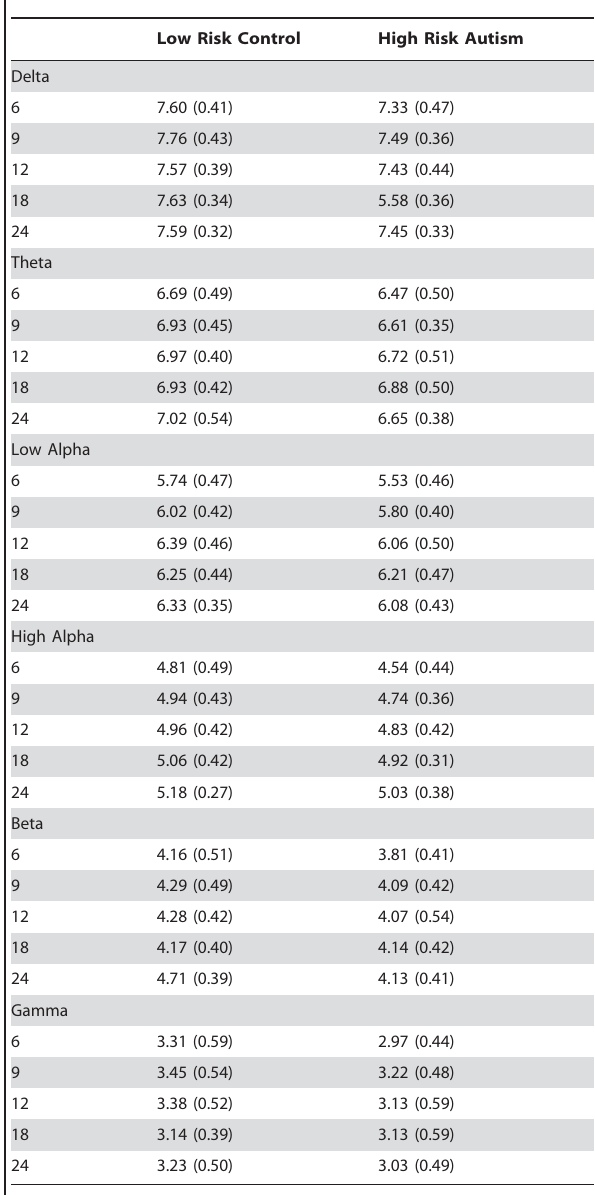
Table 4. Mean power spectral density for each group for each frequency range at each age collapsed across